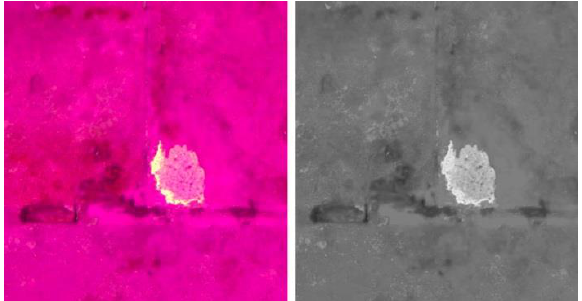
Figure 7. Ghent trial area 1, detail: Comparison of colored and gray scale UV-florescence